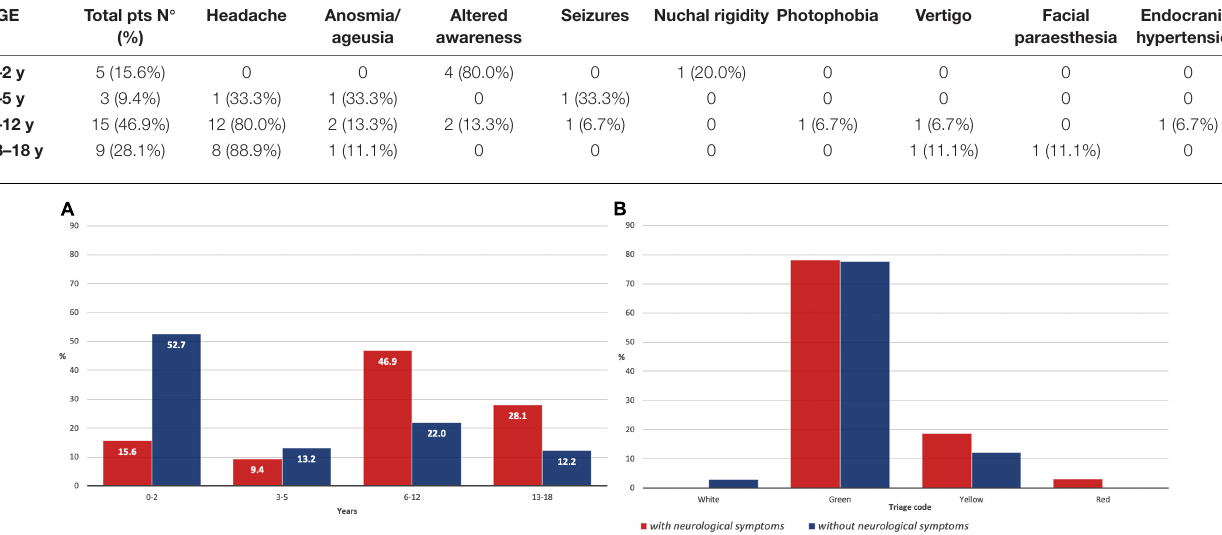
TABLE 4 | Patients with neurological symptoms stratified by age range.